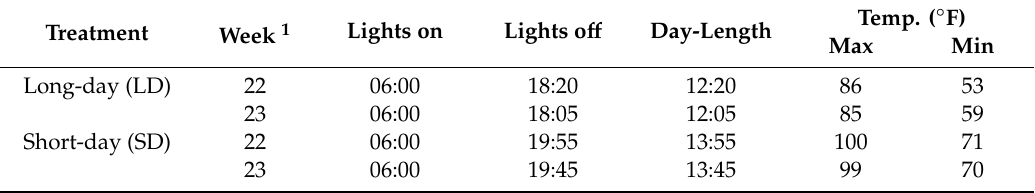
Table 1. Daylength and temperature (maximum and minimum) of the treatment chambers for the duration of one week (the week crop data was